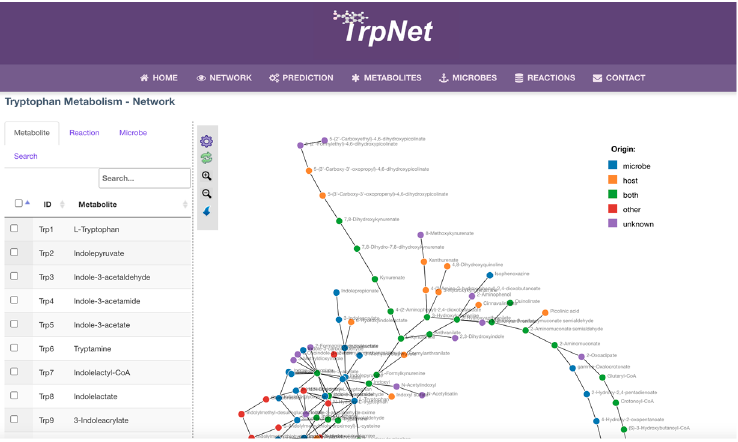
Figure 6. A screenshot of TrpNet showing the overall tryptophan metabolic network.